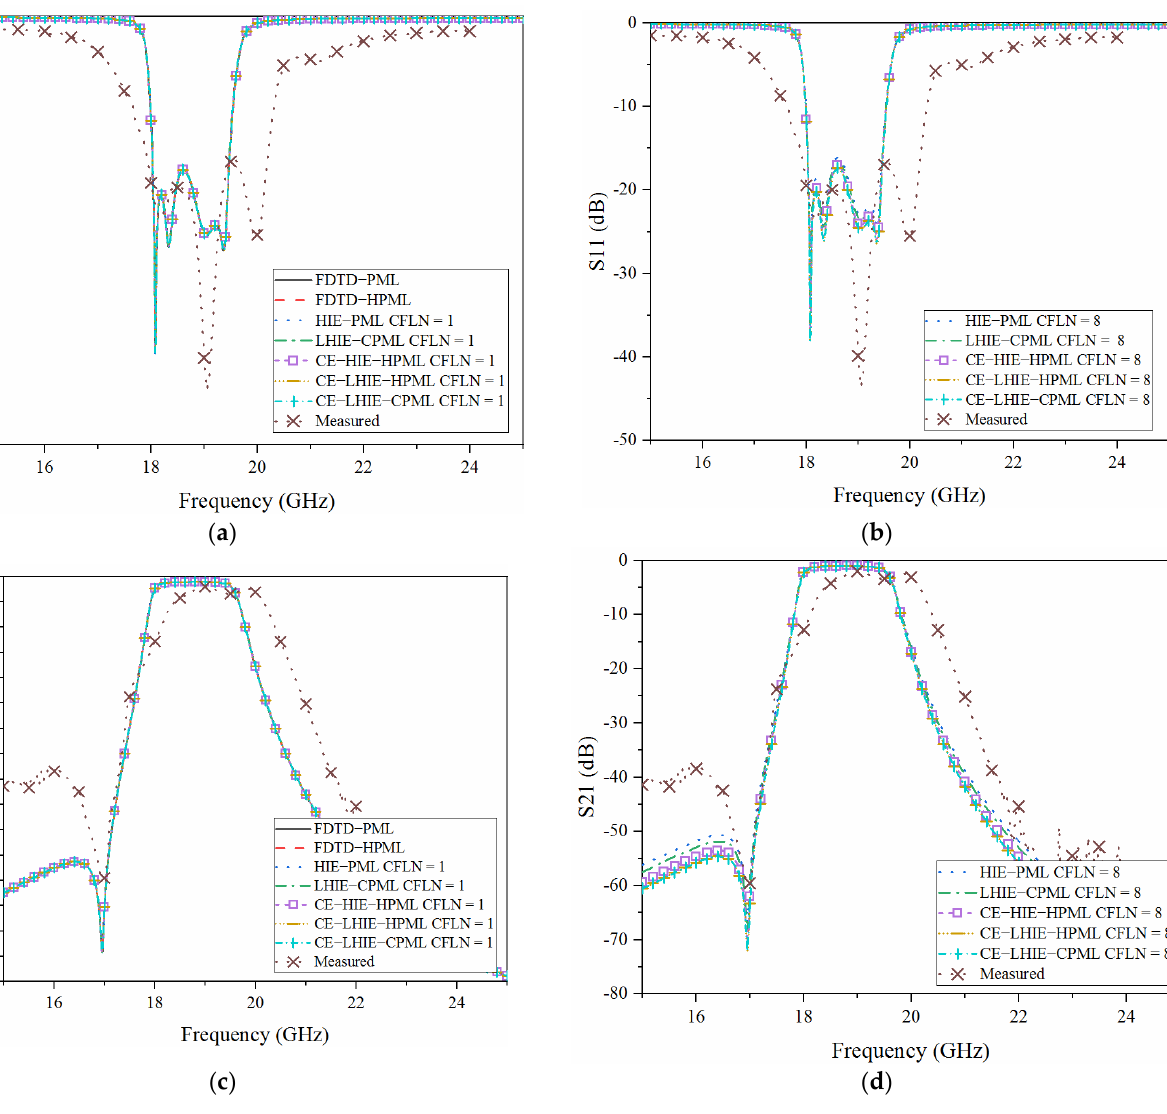
Figure 8. The scattering parameter obtained by different PML algorithms: ( a ) S11 with CFLN = 1; ( b ) S11 with CFLN = 8; ( c ) S21 with CFLN = 1; ( d ) S21 with CFLN = 8.